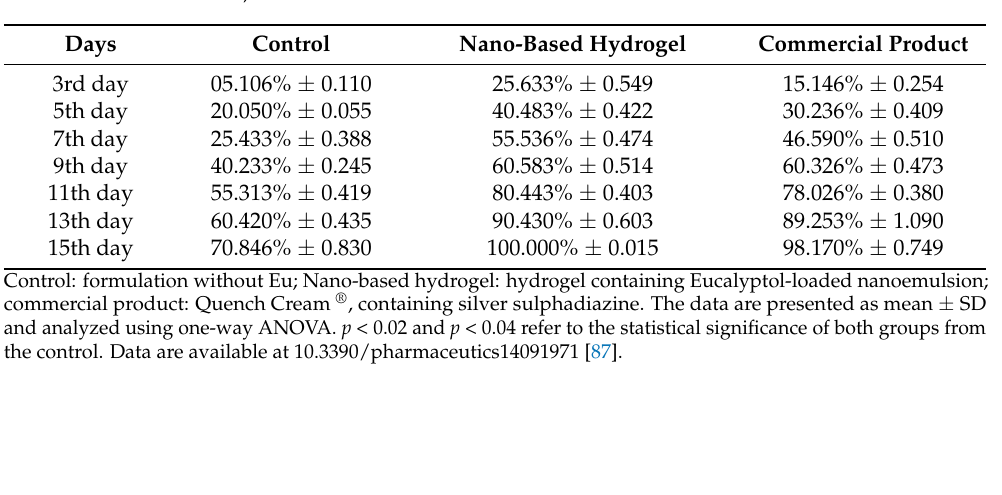
Table 3. Wound contraction percentage over the treatment schedule with nano-based hydrogel, commercial formulation, and